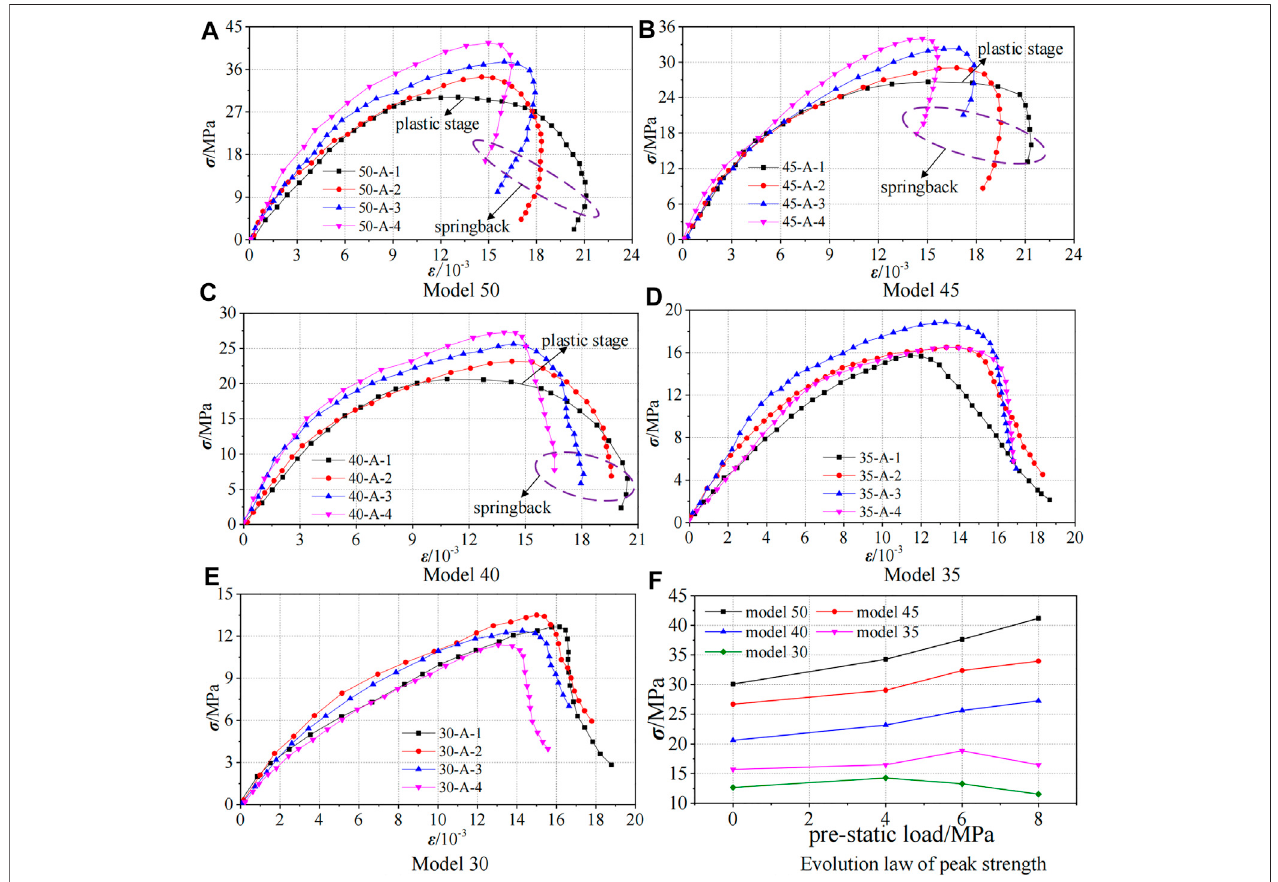
FIGURE 10 | (A – E) Strength evolution of specimens under different static loads at maximum strike velocity; (F) Evolution law of peak strength of each model.